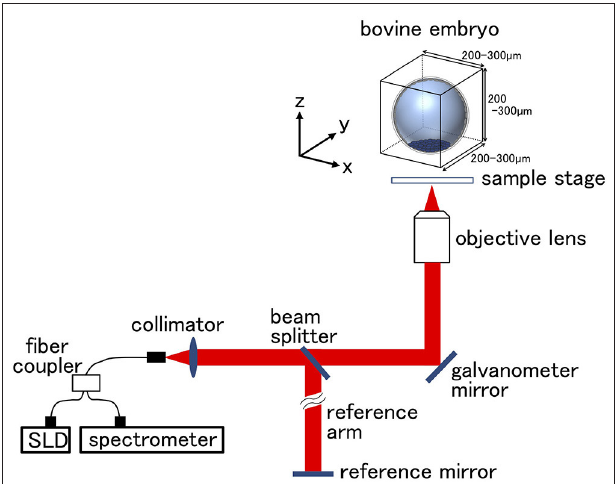
FIGURE 1 | Optical coherence tomography (OCT) setup. The super luminescent diode (SLD) output is coupled into a single mode fiber and split at the fiber coupler into the embryo sample and reference arms. Reflections from the two arms are combined at the coupler and detected by the spectrometer. Scanning scale for the bovine embryo was 200–300 µ m in each direction. Longitudinal imaging was performed in the area of bovine